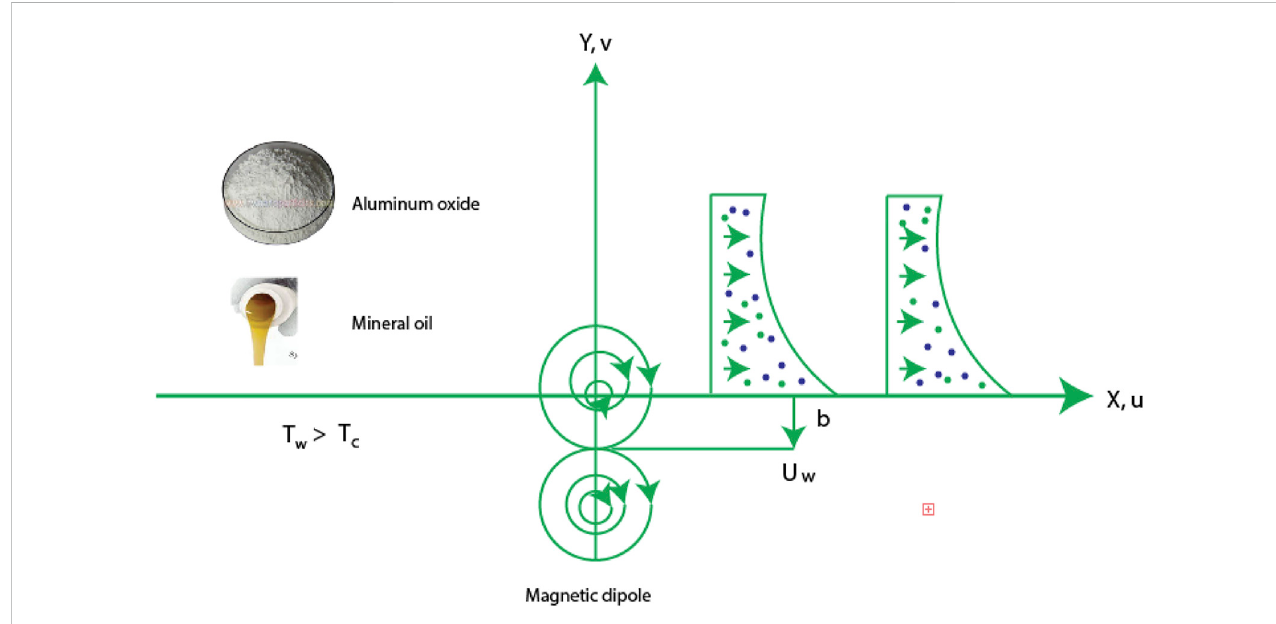
FIGURE 1 Geometry of a fl at plate including magnetic dipole.